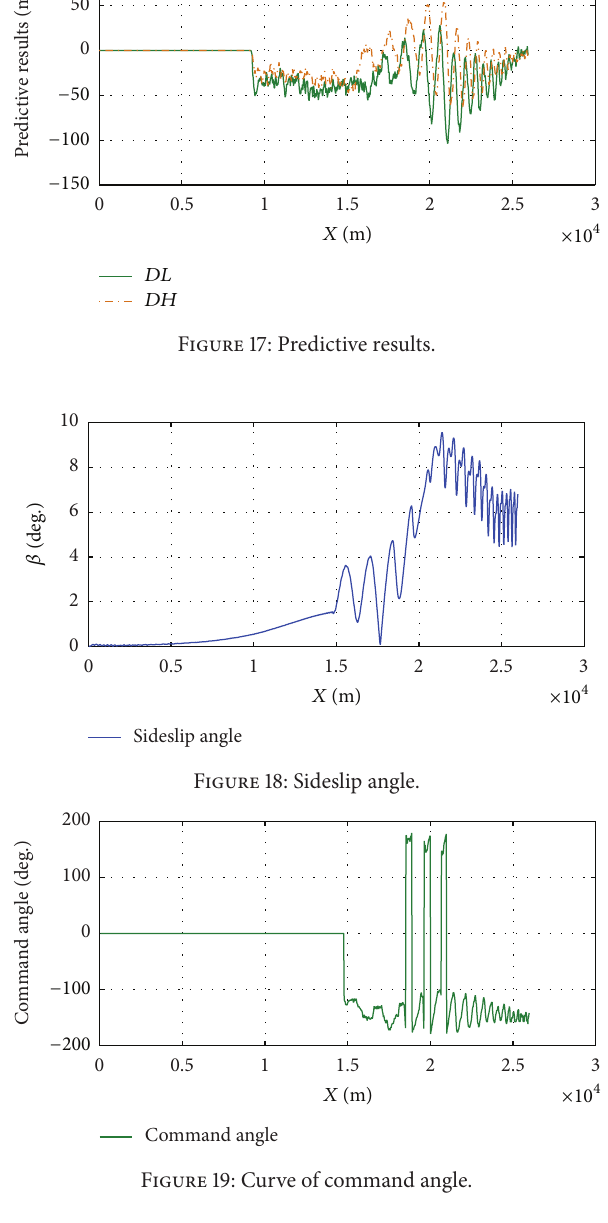
Figure 19: Curve of command